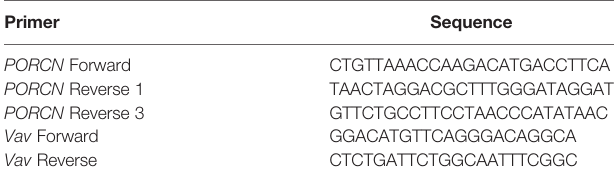
PRIMERS | Genotyping primer